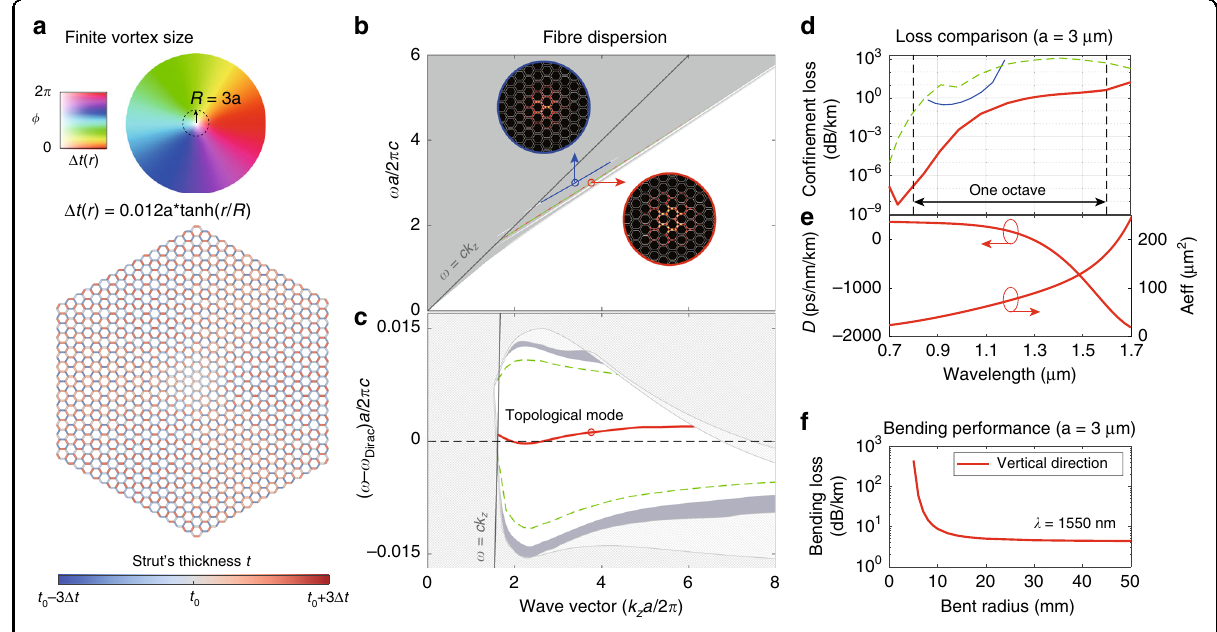
Fig. 6 Octave SPSM in a continuous Dirac-vortex fi bre with a fi nite vortex size. a Fibre structure with 16 cladding periods in radius. The colour wheel represents the phase and amplitude of the generalised Kekulé modulation. b Complete fi bre dispersion in absolute frequency. First topological mode (red line) and higher-order doublet modes (green dotted line) in the fi rst topological bandgap, as well as a second topological mode (blue line) in the second topological bandgap at higher frequency. The mode pro fi les ( b z (cid:2) Re ½ E (cid:3) ´ H (cid:4) ) of the two topological modes are shown in the insets, circled with different colours for clarity. c Fibre dispersion in frequency relative to the original nodal-line frequency. d Con fi nement losses of the guided modes. e Dispersion parameter and effective area of the fi rst topological mode. f Bending loss of the fi rst topological mode at λ = 1550